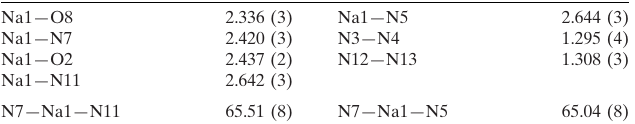
Selected geometric parameters (A˚ , (cid:3) ).